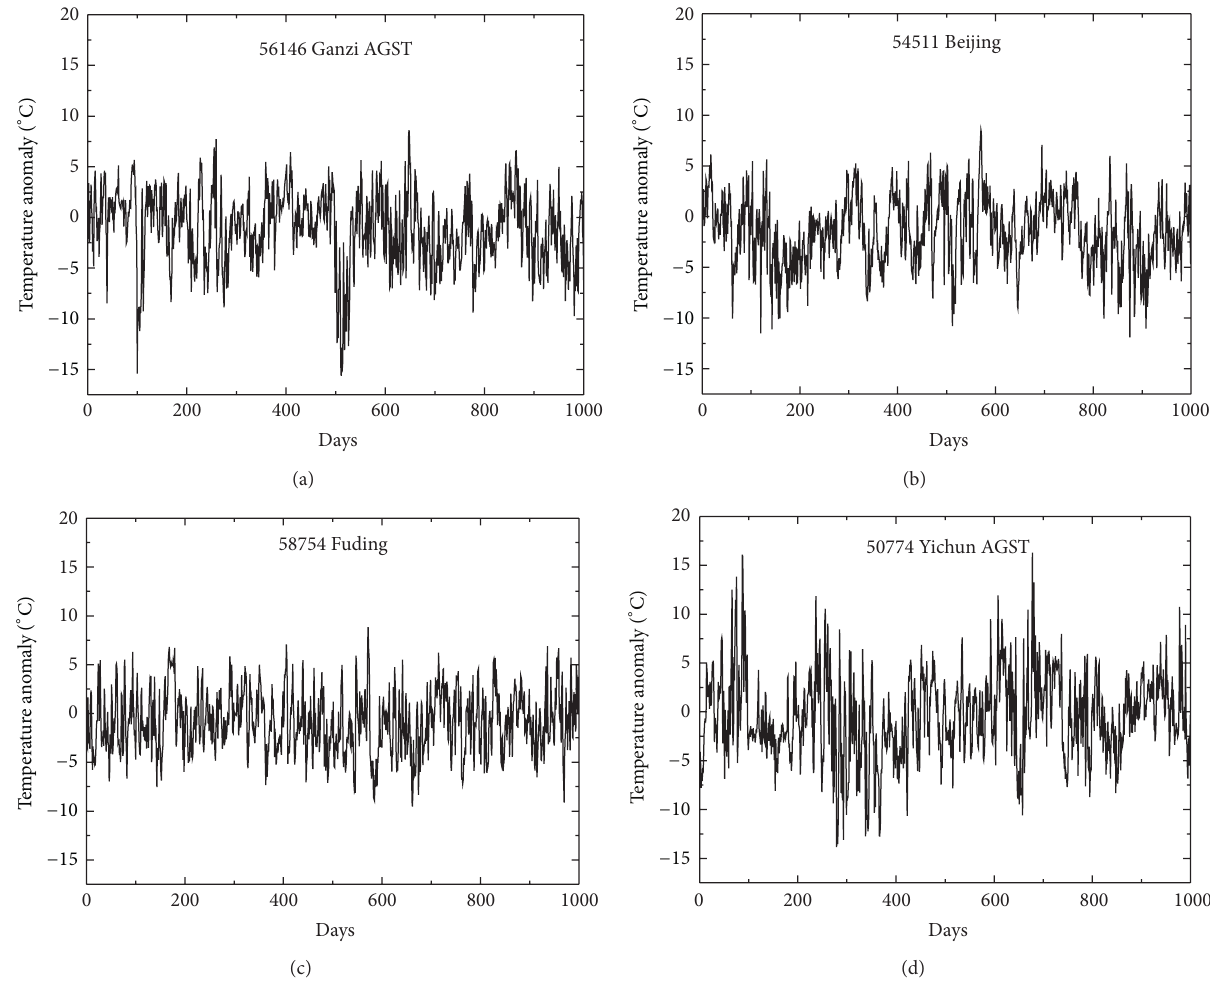
Figure 2: Temporal variations of the four anomaly AGST series for about three years. (a) The station Ganzi in the Southwest of China. (b) The station Beijing in the North of China. (c) The station Fuding in the Southeast of China. (d) The station Yichun in the Northeast of